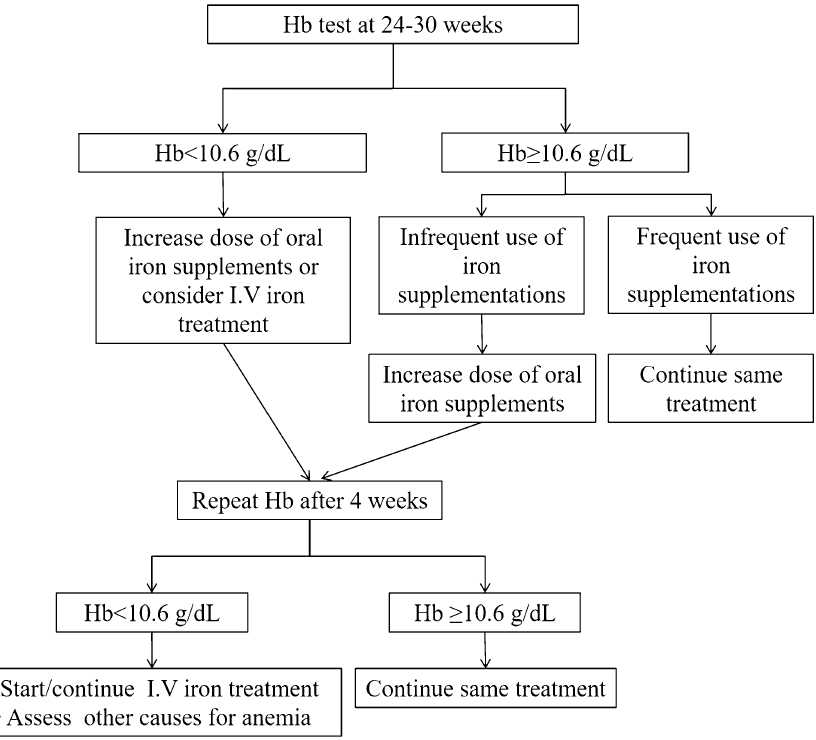
Figure 2. Suggested gestational anemia treatment flow chart based on hemoglobin values and frequency of iron supplementation use. Hb, hemoglobin; I.V